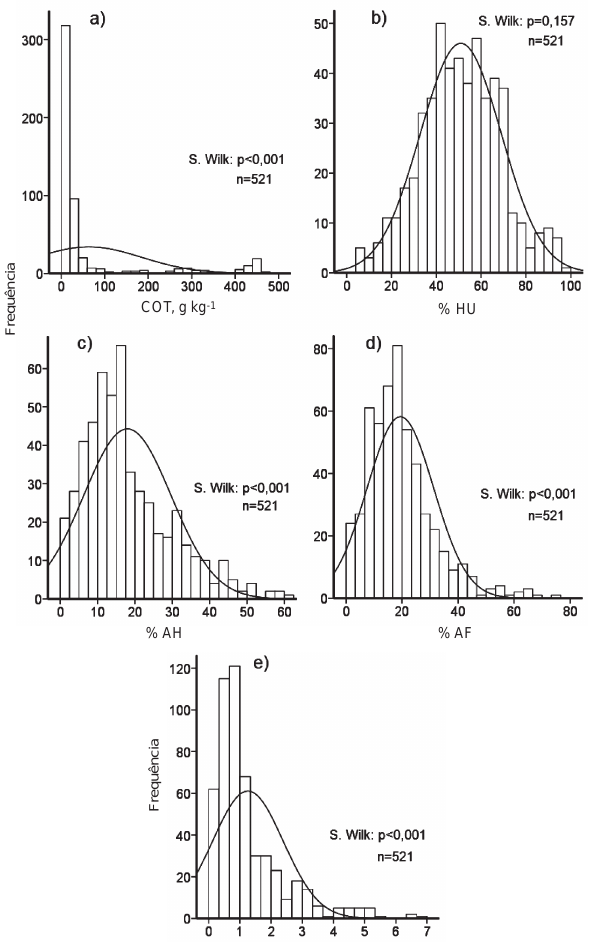
Figura 1. Distribuição geral de frequência de teores de carbono orgânico total (COT) e sua porcentagem na forma de ácidos húmicos (AH), ácidos fúlvicos (AF), humina (HU) e razão AH/ AF, em todas as